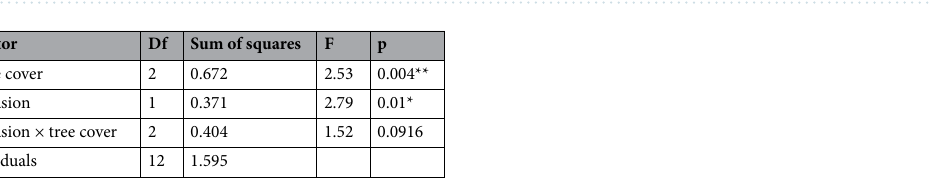
Table 3. PERMANOVA results. Significance indicated in bold as follows: *p < 0.05; **p < 0.01.